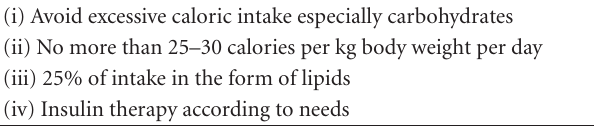
Table 7: Recommendations for adequate nutritional support during glucose control